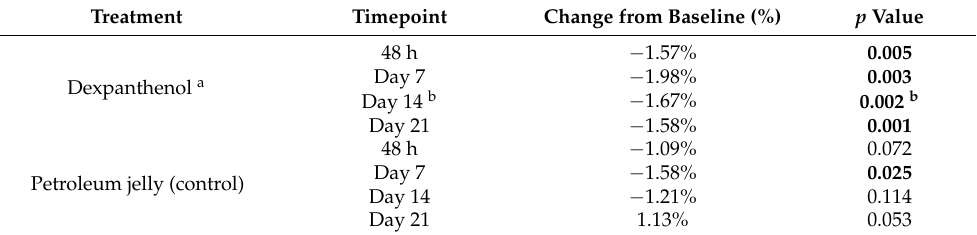
Table 4. Mean change of thermographic values versus baseline after ablative laser (Study